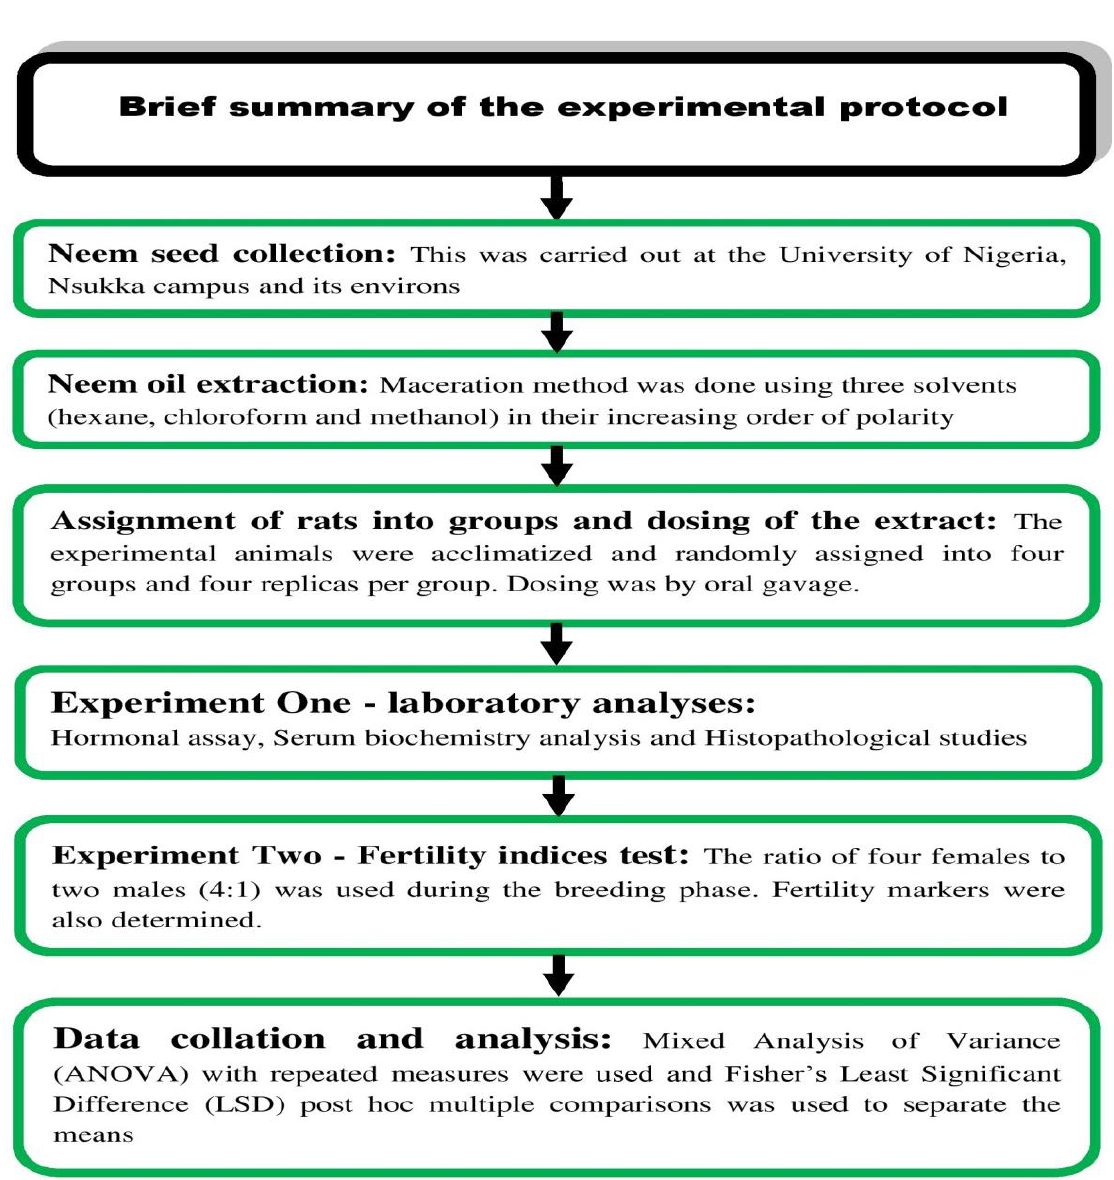
Figure 1. A schematic flow chart showing an overview of the experimental design.